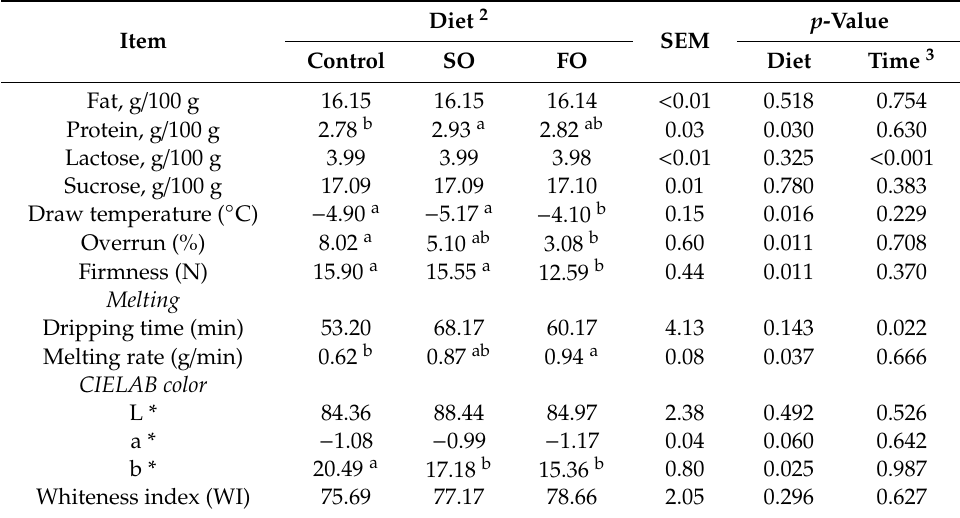
Table 5. Calculated composition and physical properties of ice creams from cows supplemented with control, soybean oil (SO), and fish oil (FO) 1